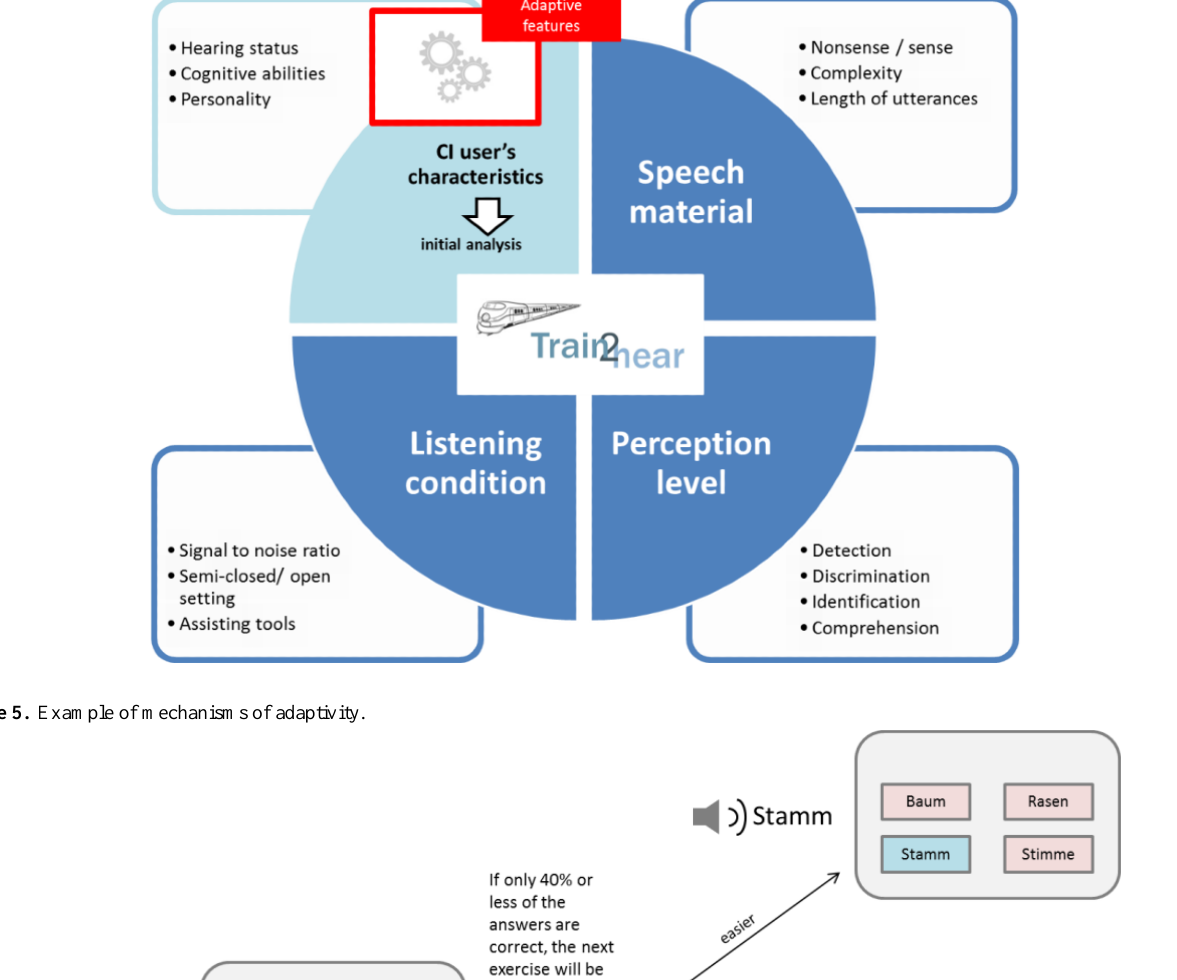
Figure 4. Dimensions of adaptivity (theoretical framework). CI: cochlear implant.